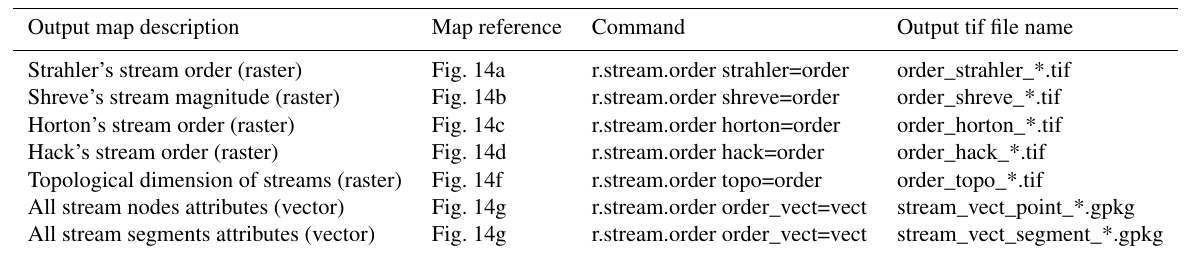
Table 6. Stream order raster and vector files computed with the r.stream.order GRASS GIS module, the map reference corresponding to Fig. 14, the specific GRASS GIS command, and the layer output